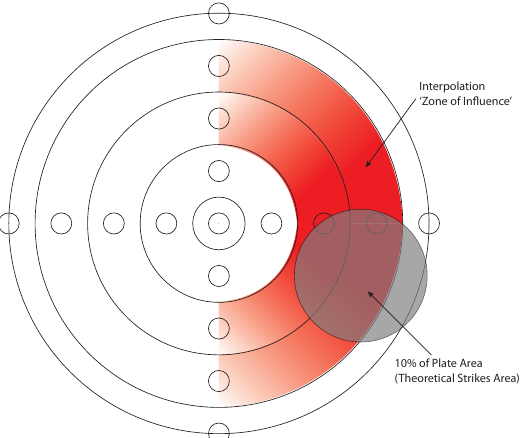
Figure 10. Demonstrating the difference between actual total discrete strike area (shown here as 10% of the plate area) versus the ‘zone of influence’ of the existing interpolation. It is assumed that if a proportion of the plate area is struck, the same proportion of the HPBs will be struck also, a strike area of 3142 mm 2 results in a ‘zone of influence’ of 9817 mm 2 in this example case.